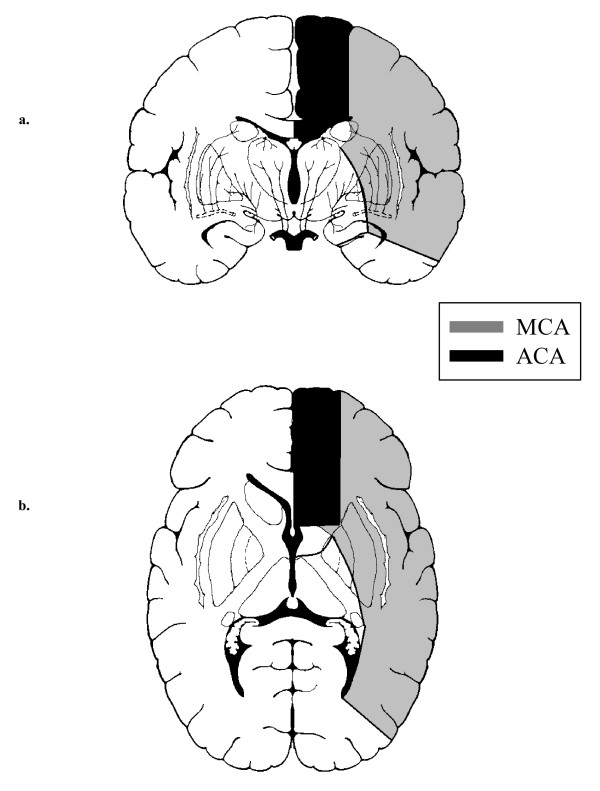
Arterial territories of the middle (MCA) and anterior (ACA) cerebral arteries. a. Coronal view, b. Axial view.